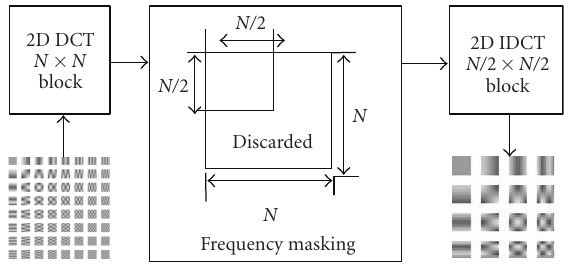
Figure 3: Spatial resolution downsizing by frequency